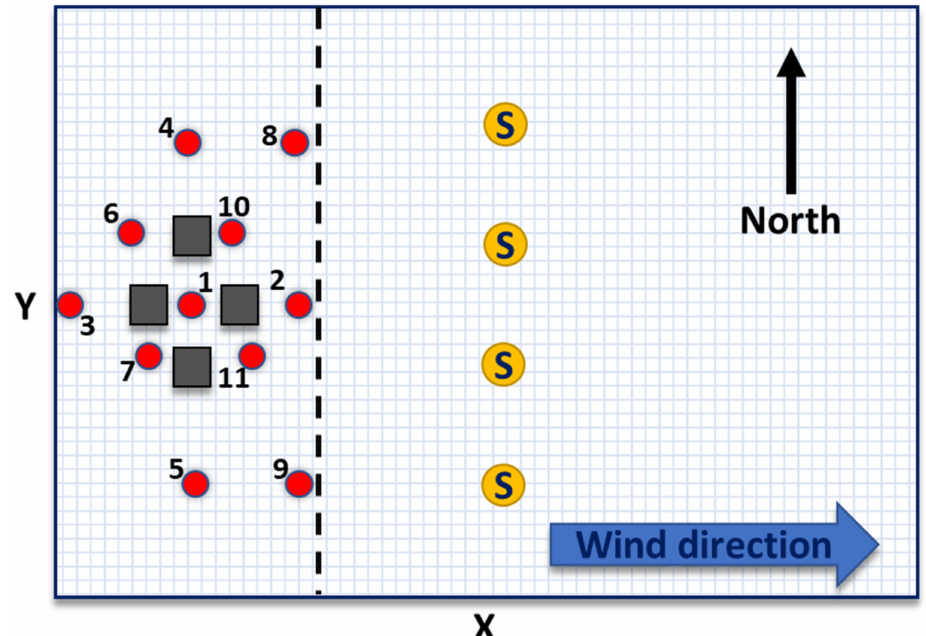
Figure 1. Diagram (not to scale) of the setup of the test site: a flat 1225 m × 850 m surface is partitioned into 25 m × 50 m grid units marked by the gray lines. Four (50 m × 50 m × 20 m) buildings are located in the western section of the site and are marked by squares. Possible leak sources are indicated by the red dots. The yellow circles depict an example of a possible sensor (S) array positioned perpendicular to the wind direction. The dashed blue line 375 m from the western side represents the industrial site